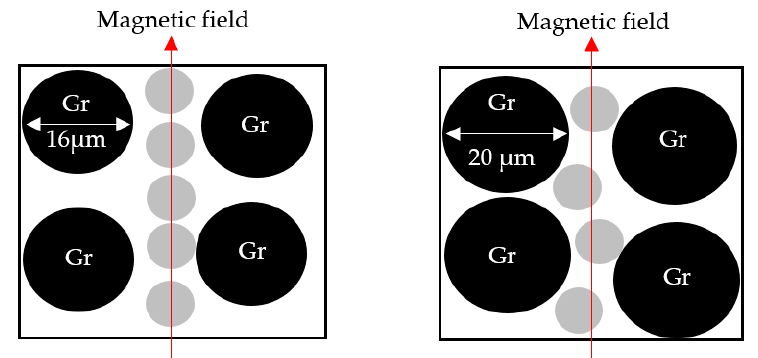
Figure 10. The difference between graphite content used by Tian et al, 20 µm ( right ), and current research, 16 µm ( left ). The increase in particle size limits particle mobility.